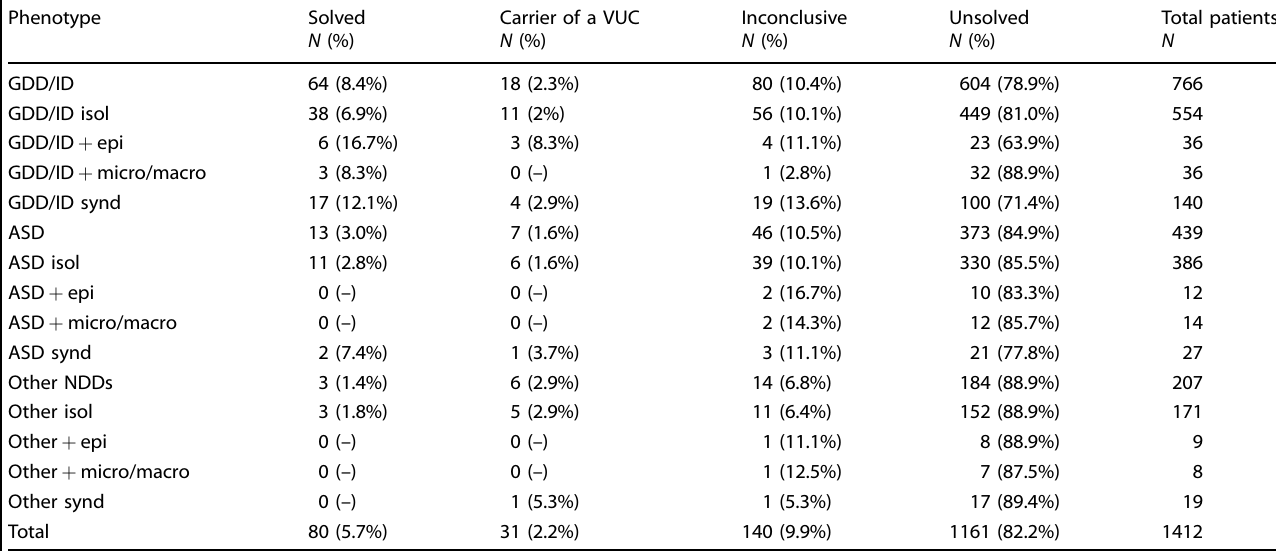
Table 1. Number and percentage of patients in each of the groups based on the aCGH results and strati fi ed by phenotype category and